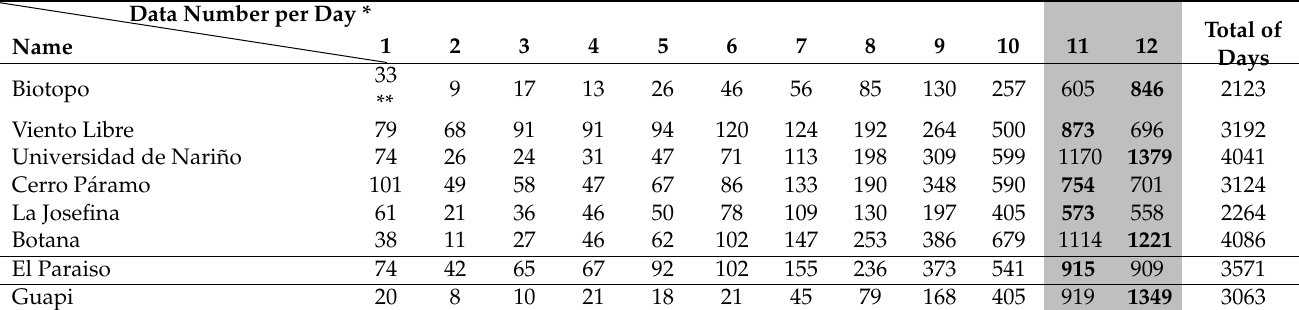
Table 10. Classification of days according to irradiance recording per day. The rows contain the number of days classified by the amount of data measured between 6:00 and 18:00.